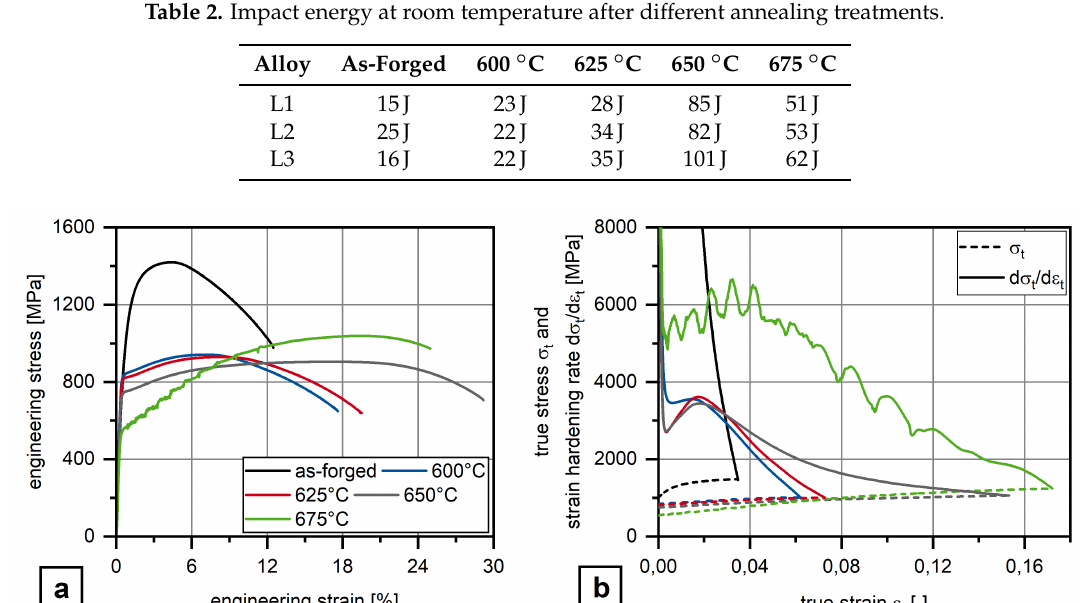
Figure 4. Annealing influence on the stress-strain-curve ( a ) and strain hardening curves ( b ).